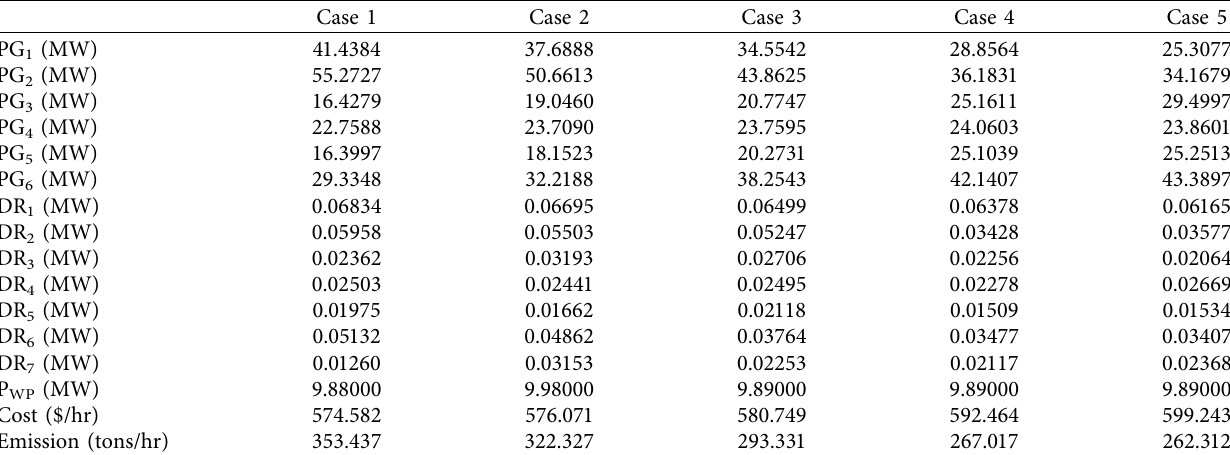
Table 12: Optimized variables for strategy B